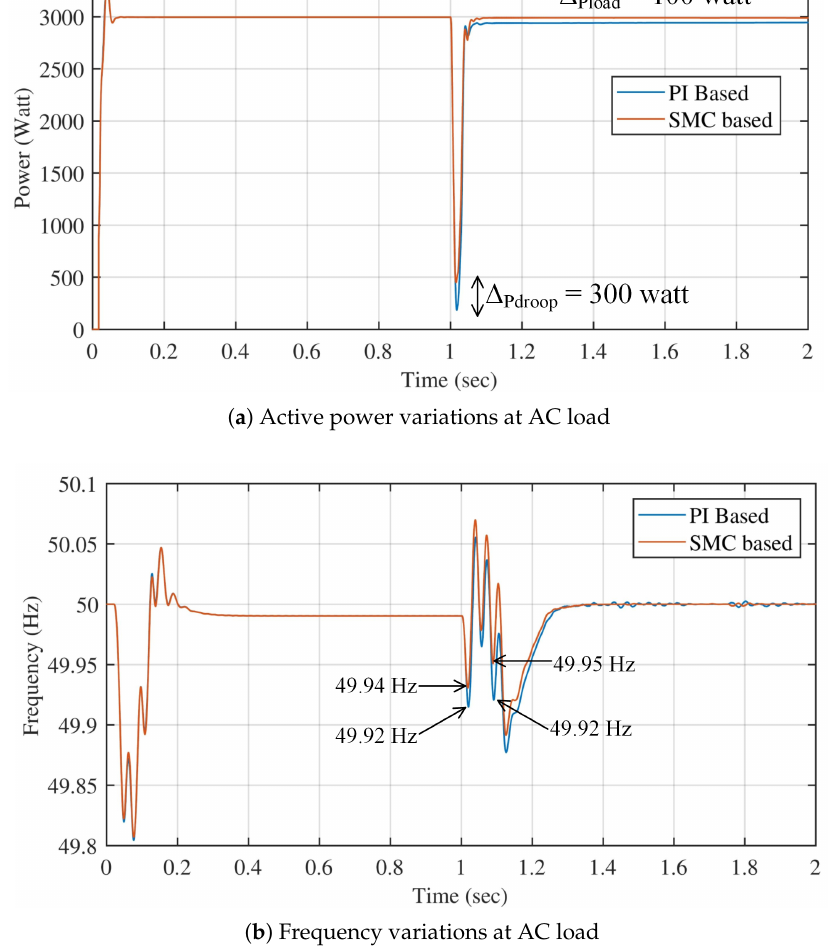
Figure 9. Case 2: Power flow from AC to DC